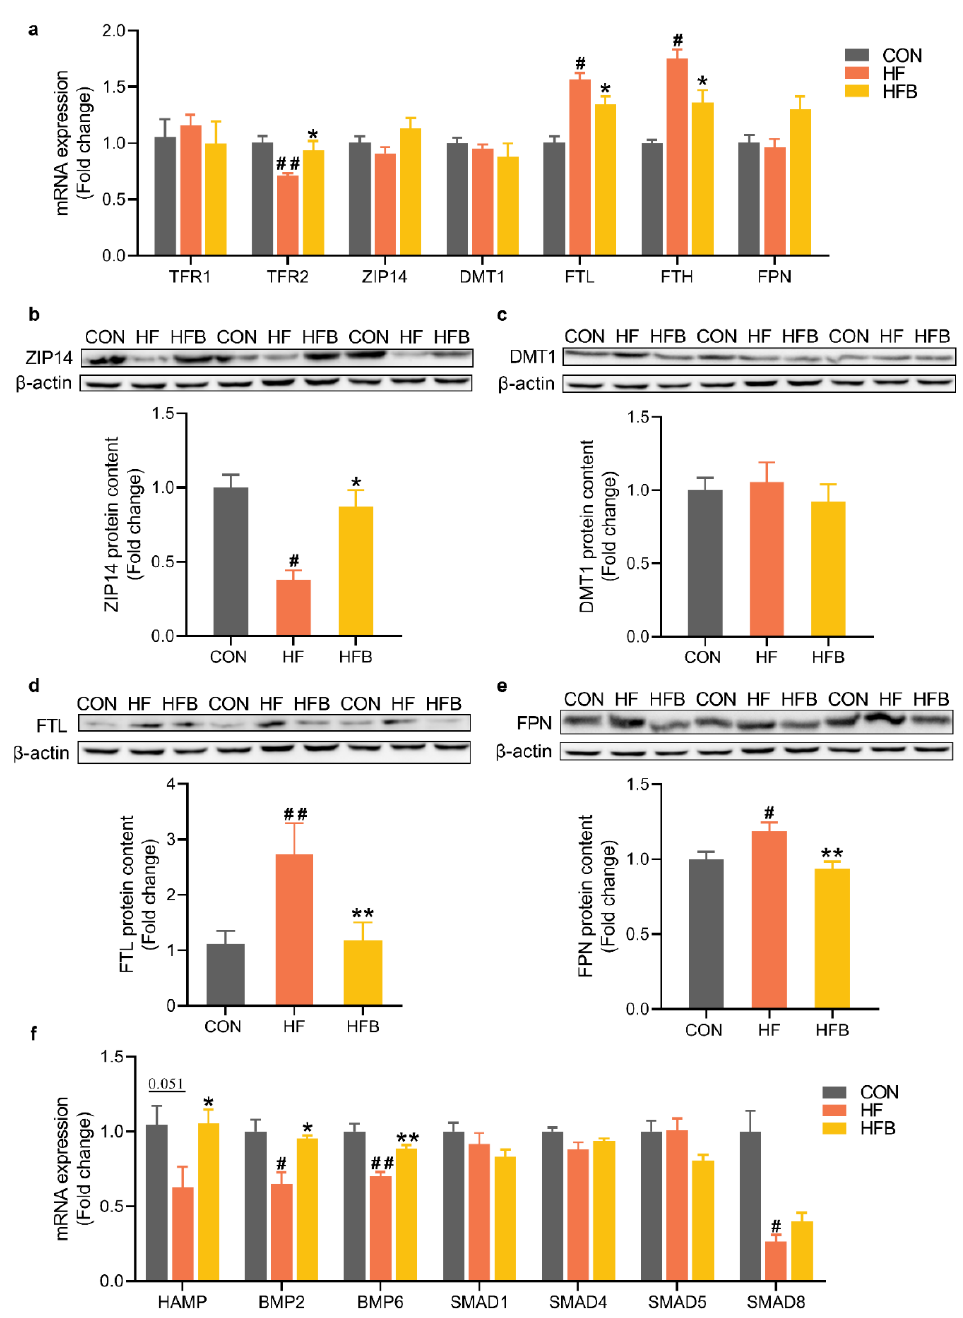
Figure 3. Hepatic genes expression involved in iron metabolism. ( a ) Hepatic mRNA expression of iron metabolism ( n = 6). ( b ) Protein content of ZIP14 in the liver ( n = 6). ( c ) Protein content of DMT1 in the liver ( n = 6). ( d ) Protein content of FTL in the liver ( n = 6). ( e ) Protein content of FPN in the liver ( n = 6). ( f ) Hepatic mRNA expression of HAMP and the upstream regulators ( n = 6). Values are means ± SEM. # p < 0.05 and ## p < 0.01 compared with the CON group. * p < 0.05 and ** p < 0.01 compared with the HF group.